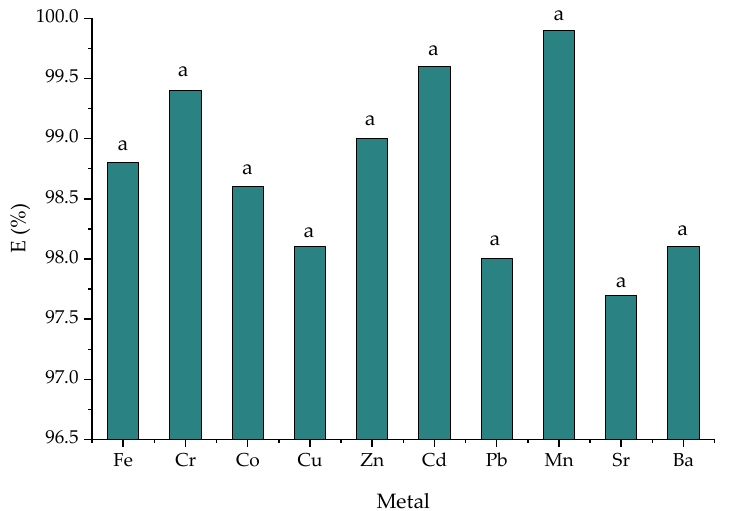
Figure 6. The metal removal efficiency in the S10 sample. Data are the mean ± standard deviation ( n = 3); the same letters show no significant difference ( p > 0.05). Table 4. Water quality index before and after zeolite